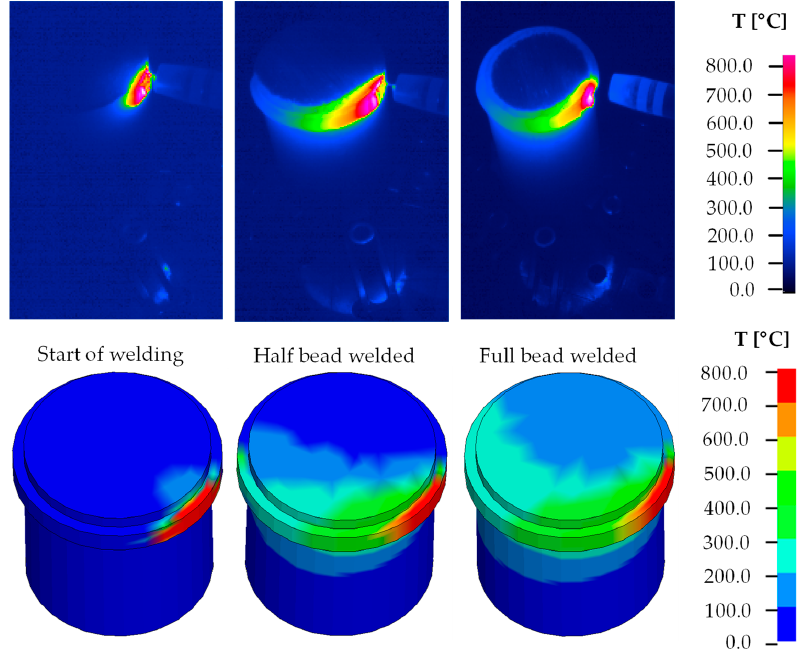
Figure 16. Temperature distribution pattern in the experiment (above) and simulation (below). Results indicated that the temperature development in both the experiment and the simulation followed the same trend. The heat distribution pattern on the tool’s surface can also estimate the welding path. The thermal history of two points at different locations on the tool has been compared, as shown in Figure 17. Temperature peaks indicate the moment when the heat source moves over the element. As point P1 was close to the welding bead, a higher peak was detected than P2, relatively far from the welding bead.